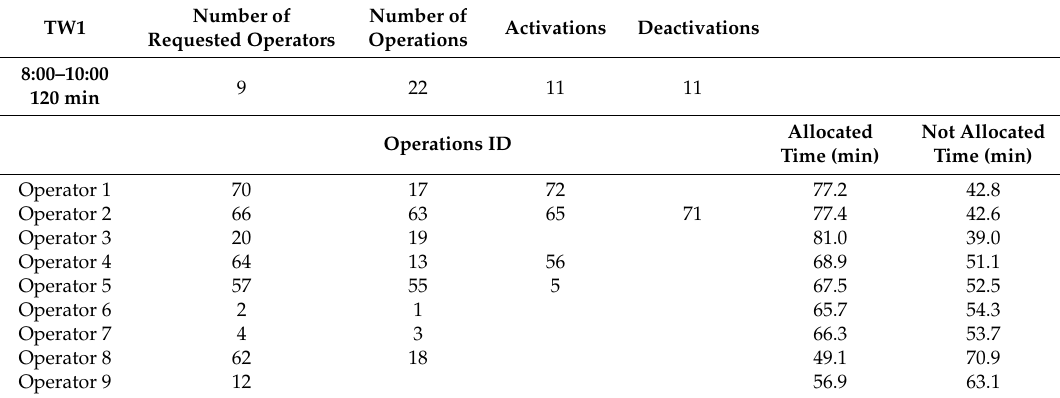
Table 3. Solution (4) provided by the proposed algorithm for TW1.